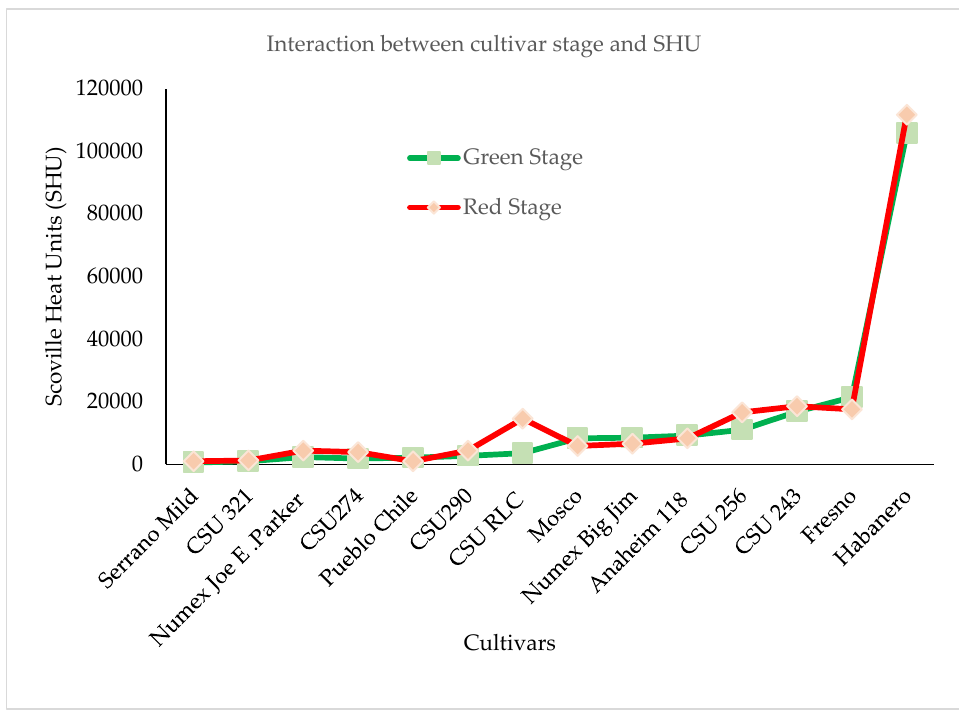
Figure 5. The interaction between cultivar and stage for SHU using Excel ver 2016. Cultivars that did not show capsaicin and dihydrocapsaicin were not included in this analysis.